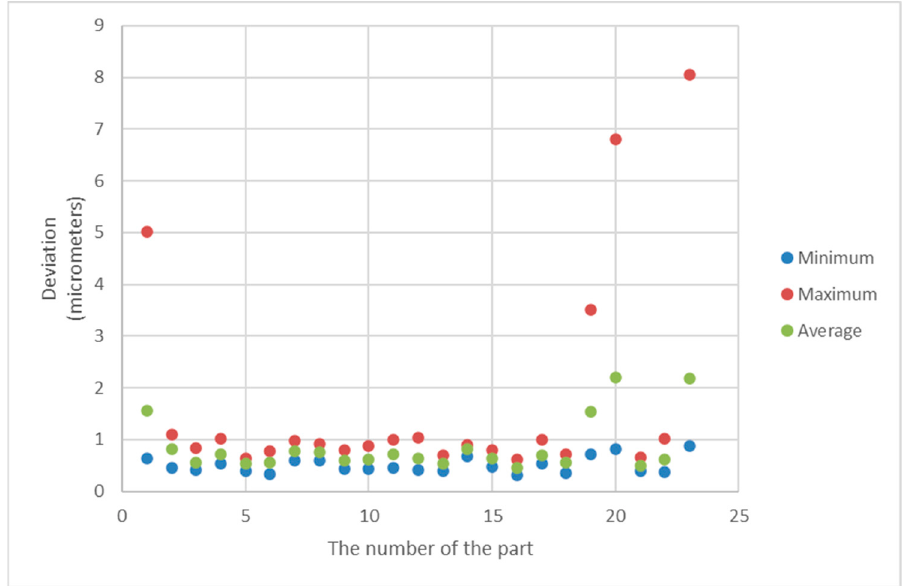
Figure 11. Minimum, maximum and average values of the form deviation for each sphere from the first